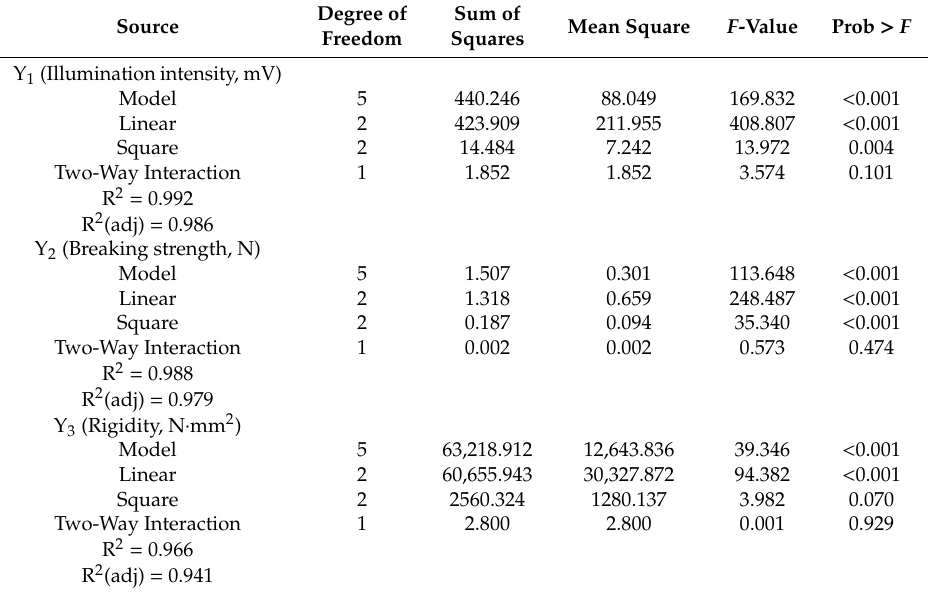
Table 5. ANOVA for the response surface quadratic